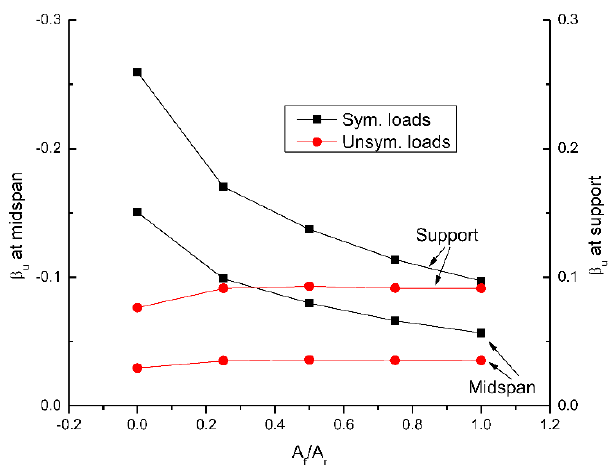
Figure 15. Change in moment redistribution at ultimate ( β u ) with the hybrid level.